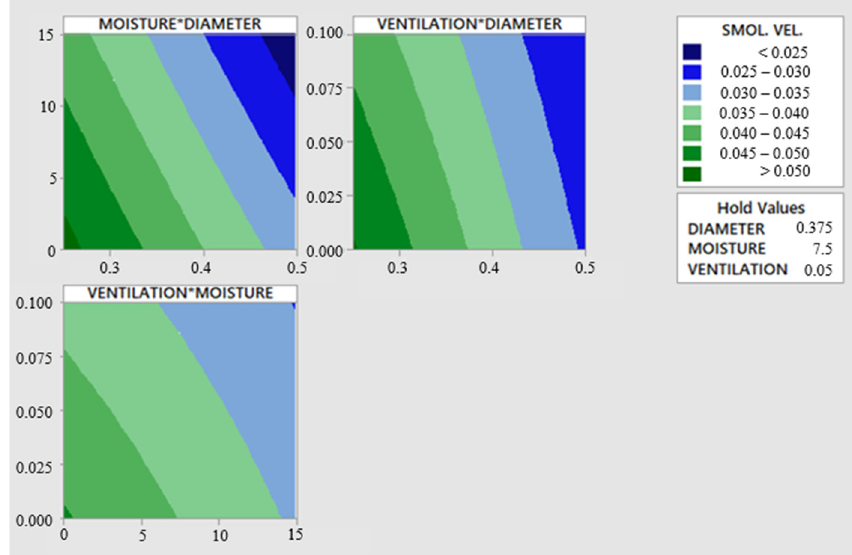
Figure 11. Contour plots of smoldering velocity.